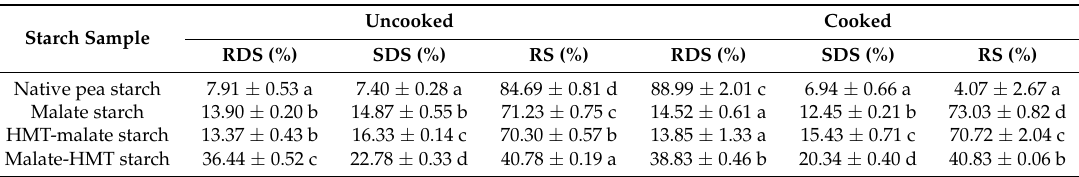
Table 1. Percentages (% w / w , dry weight) of rapidly digestible starch (RDS), slowly digestible starch (SDS), and resistant starch (RS) †